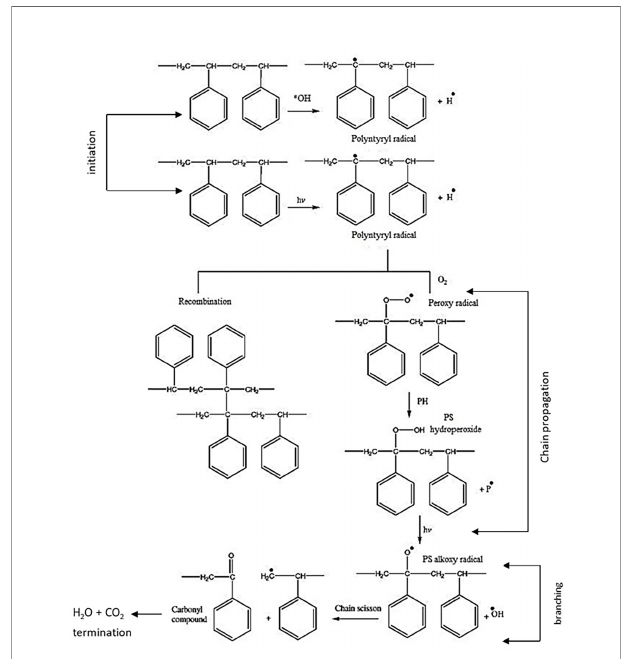
FIGURE 6 | The photocatalytic degradation mechanism of PS fi lm. Reproduced with permission (Yousif and Haddad,